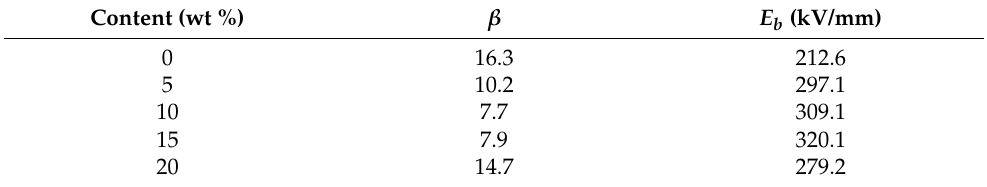
Table 1. Mechanical properties of ANF and ANF/chitosan/Al 2 O 3 composite films. Content (wt